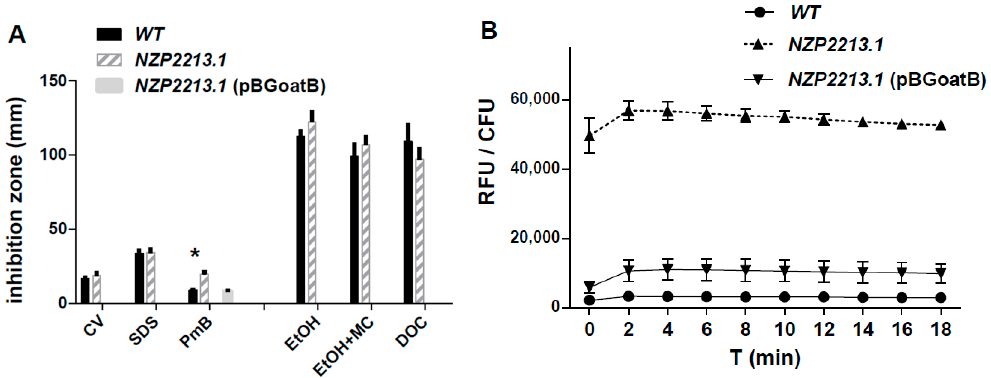
Figure 3. Surface properties of the M. loti cell wall. ( A ) Sensitivity assays; ( B ) N -phenyl-1-